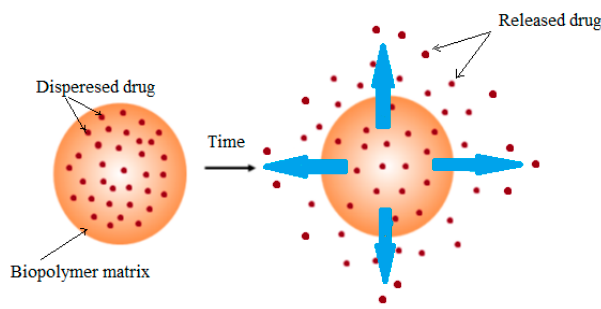
Figure 2. Drug diffusion from the biopolymer matrix containing dispersed drug.